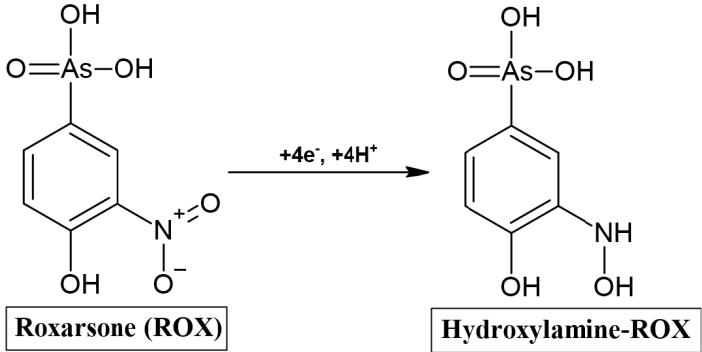
Figure 4. Schematic reduction mechanism of ROX at the GCE/CTAB.